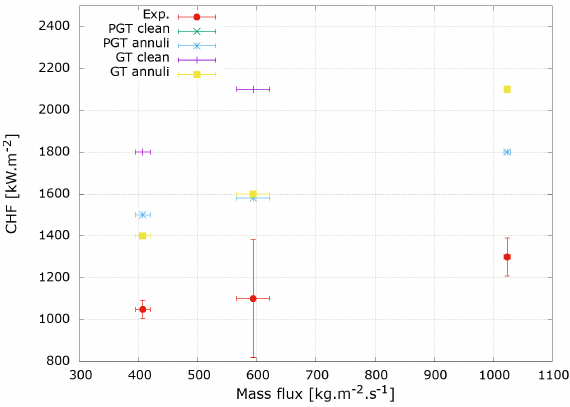
Figure 7. Comparison of CHF results against calcu- lations with PGT correlation and Groeneveld’s tables at p in = 131 kPa and T in = 62 ℃.